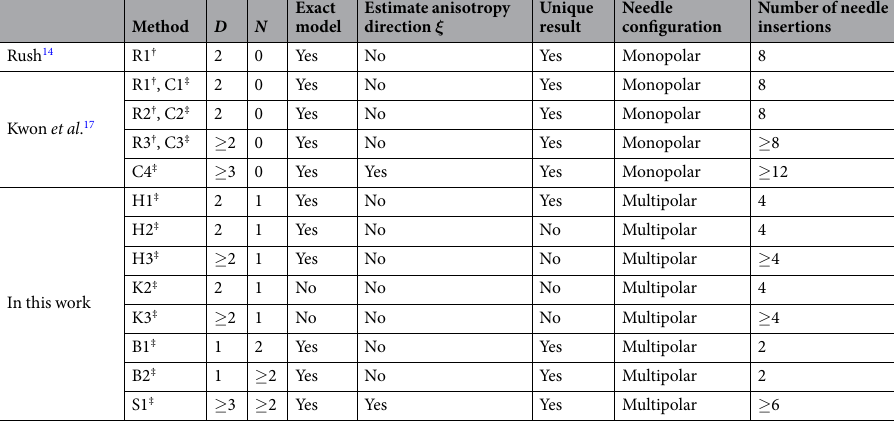
Table 1. Comparison of electrical impedance methods for the in situ measurement of anisotropic permittivity. Nomenclature: D , number of measurement angles; N , number of inter-electrodes’ distances within the same needle. †‡ Outcome: † resistivity only; ‡ resistivity and